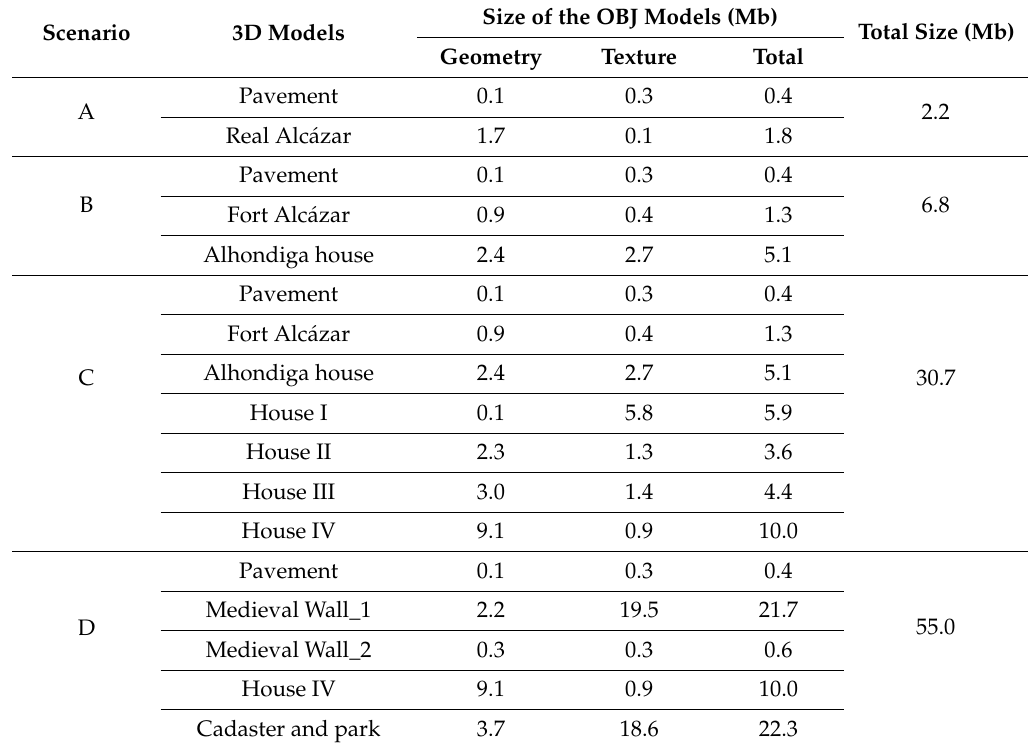
Table 5. Scenarios considered during the performance assessment.